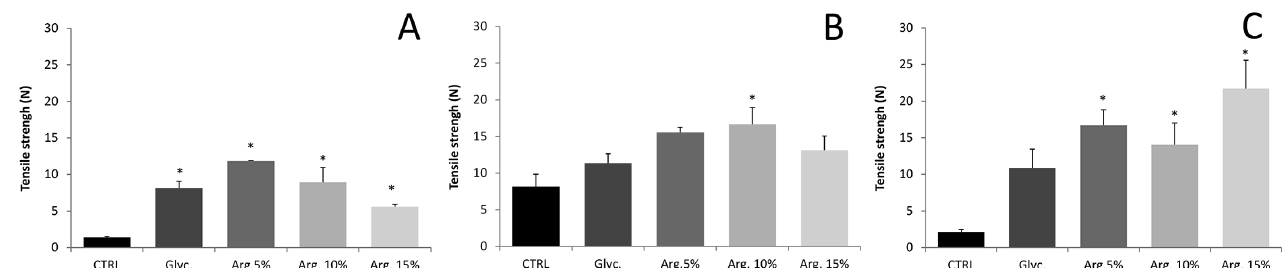
FIGURE 1 - Evaluation of the mechanical tensile strength of female mouse skin. (A) Group 1, (B) group 2, and (C) group 3. The mice were treated with glycerol only (Glyc.), dispersions of L-arginine in glycerol at 5% (Arg. 5%), 10% (Arg.10%), or 15% (Arg. 15%), or received no treatment (CTRL). P < 0.05; * versus CTRL; (3 ≤ n ≤ 5).